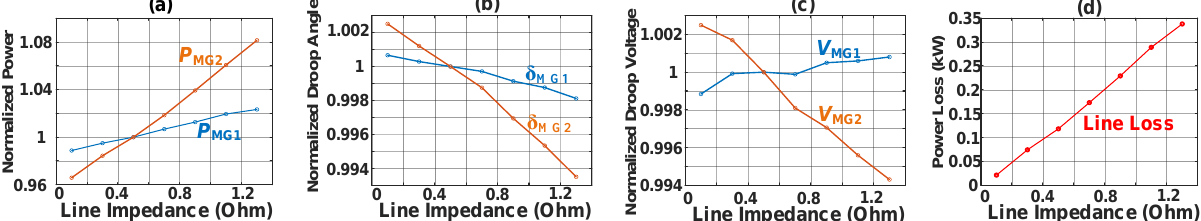
Figure 20. Sensitivity analysis with variation of interconnecting line impedance ( a ) power ( b ) droop angle ( c ) droop voltage ( d ) line loss.